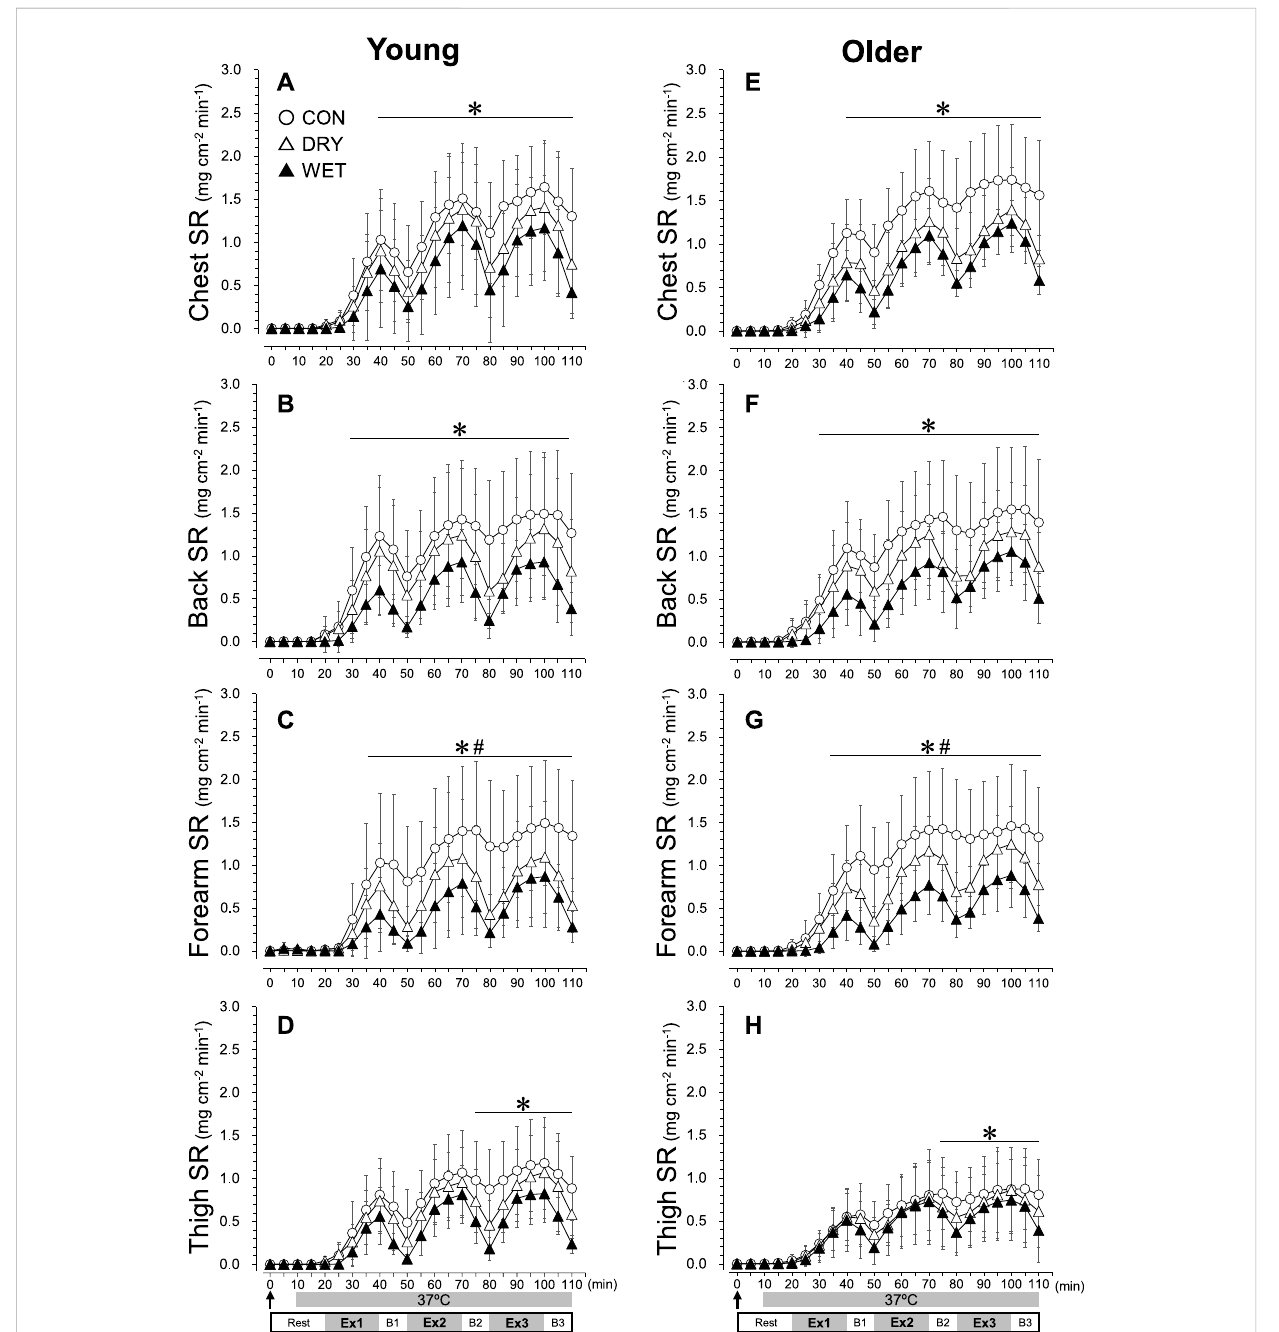
FIGURE 2 Regional sweating rate (SR) responses on the chest (A, E) , back (B, F) , forearm (C, G) , and thigh (D, H) during three bouts of intermittent exercise (Ex1 – 3) in hot conditions (37 ° C, 50% RH) interspersed by three breaks (B1 – 3) in the young (left) and older (right) groups while wearing a dry inner t-shirt without ventilation garment fanning in the control (CON, open circles), a dry inner t-shirt with ventilation garment fanning (DRY, opened triangles), and a wetted inner t-shirt with ventilation garment fanning (WET, closed triangles). The arrow indicates the start of fanning (DRY) and wetting and fanning (WET).*Signi fi cantlydifferentforCONvs.WETtrial, p < 0.05.#Signi fi cantlydifferentforDRYvs.WETtrial, p < 0.05.§Signi fi cantlydifferentforCONvs.DRY trial, p < 0.05. Data are expressed as the mean ± SD for eight